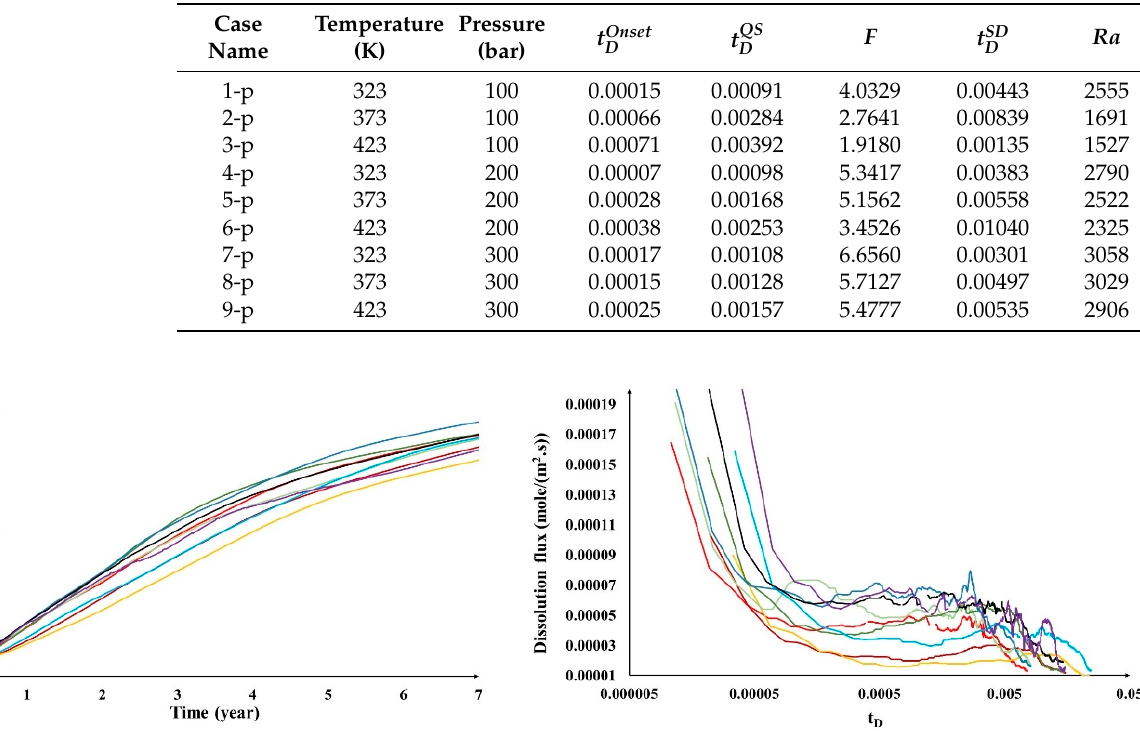
Figure 2. The averaged dissolved CO 2 and dissolution flux for the pure case. Legends for left- and right-hand subplots are same. Table 3. Details of the pure cases.